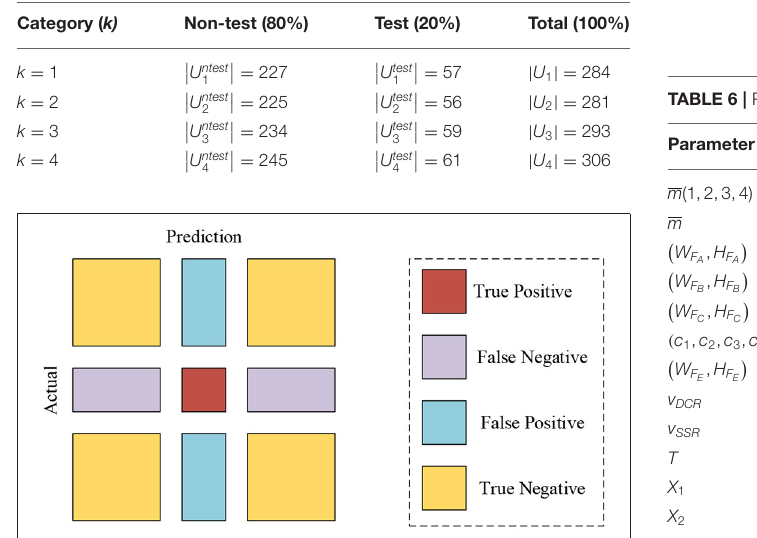
FIGURE 8 | Definition of TP, FN, FP, and TN per category.